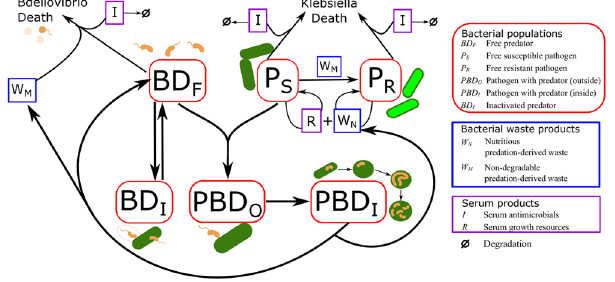
Figure 1. Schematic diagram of relationship between model variables based on biological mechanisms. The Ca/ HEPES buffer model has eight variables: free B. bacteriovorus predators ( BD F ), uninfected predation-susceptible K. pneumoniae prey ( P S ), uninfected predation-resistant K. pneumoniae prey ( P R ), prey with predator attached outside ( PBD O ), invaded prey with predator on the inside ( PBD I ), inactivated predator ( BD I ), nutritious waste ( W N ) and non-degradable waste ( W M ). The serum model has an additional two variables serum growth resources (R) and serum antimicrobials (I). Detailed description of the biological mechanisms can be found in the supplementary